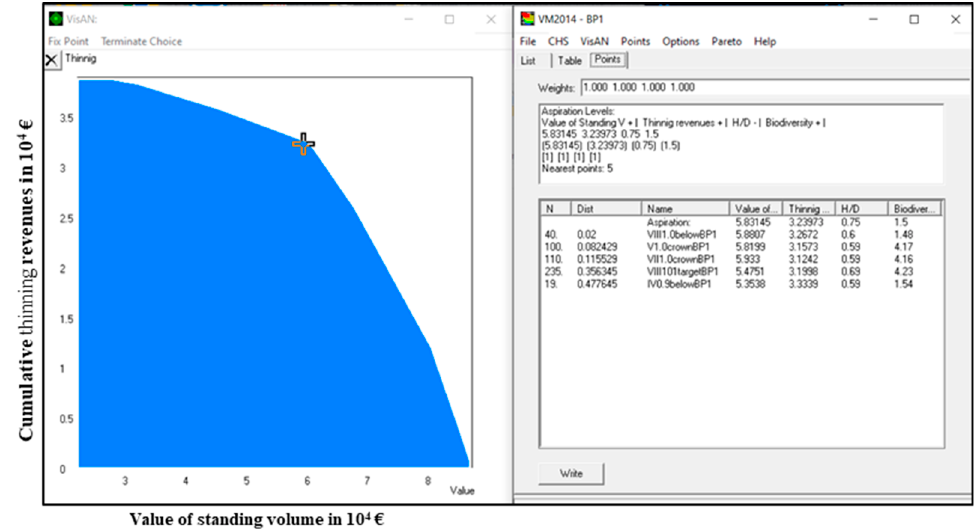
Figure 5. Example of a selection of candidates for an optimal tending system with the shortest distance to the target point determined in the VisAn software environment. Table 3. Optimal alternatives of tending treatments for representative forest stands.